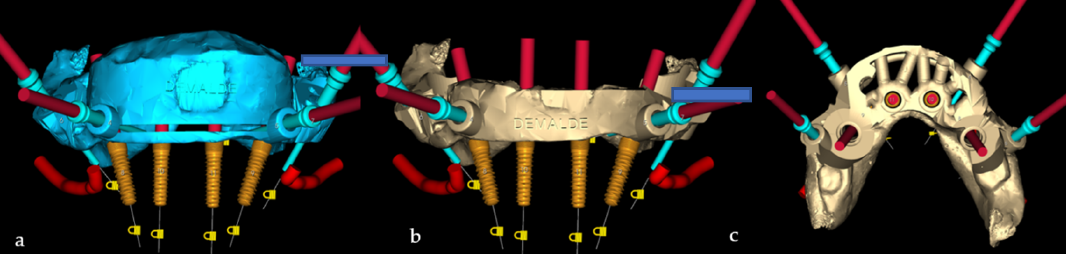
Figure 5. ( a ) Osteotomic and positional guide; ( b , c ) implant Guide in sagittal and coronal view.